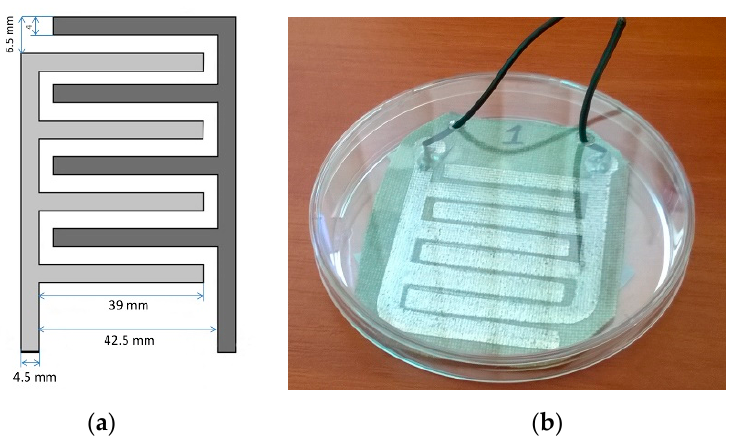
Figure 2. ( a ) Geometry of the produced interdigitated electrodes (IDEs); ( b ) photo of the pro- duced